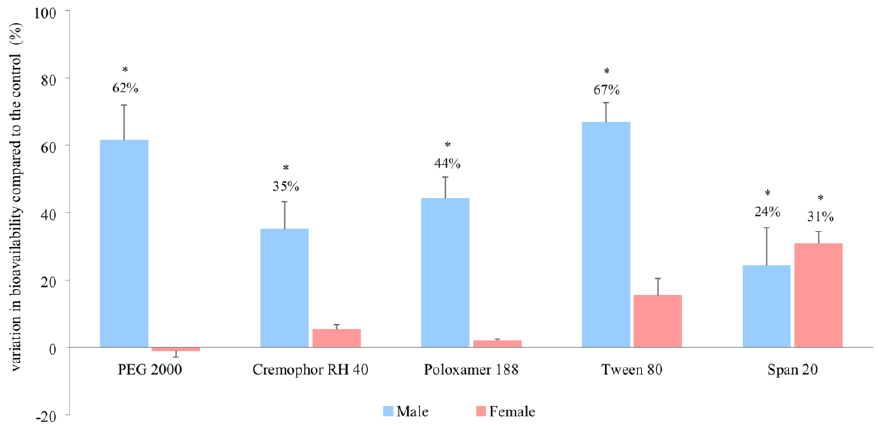
Figure 4. Percentage change in ranitidine bioavailability (AUC 0 – infinity ) in the presence of excipients in male and female Wistar rats (mean ± SD, n = 6). * Values are statistically different between the control (i.e. no excipient) and the excipient groups at p < 0.05.